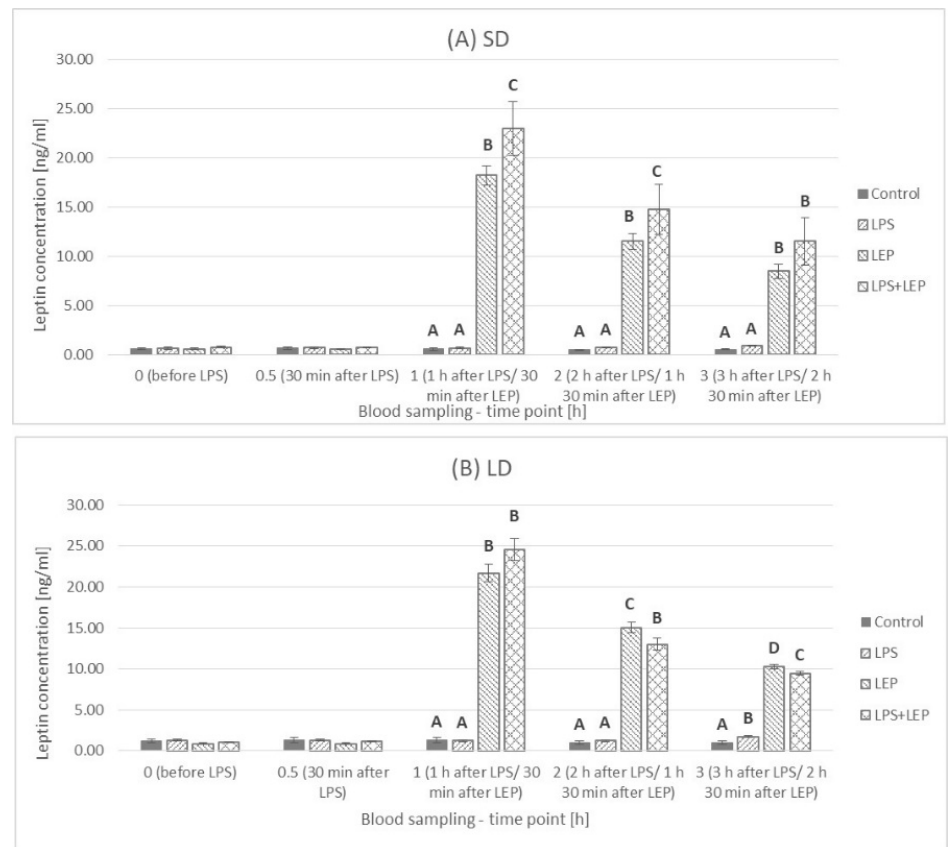
Figure 3. Plasma leptin concentration—comparison among the experimental groups (Control, LPS, LEP and LPS + LEP) for short-day (SD) ( A ) and long-day (LD) ( B ) photoperiod for each selected time point separately; A–D—bars with different letters differ significantly within each time point according to the two-way analysis of variance (ANOVA) followed by Fisher’s post-hoc test ( p ≤ 0.05) ( n = 6). Groups: control—saline injection, LPS—lipopolysaccharide injection at a dose of 400 ng/kg of body mass at a 0 h time point, LEP—leptin injected at a dose of 20 µ g/kg of body mass at a 0.5 h time point, LPS + LEP—LPS and LEP injections at the same doses and time points as those in the LPS and LEP groups.